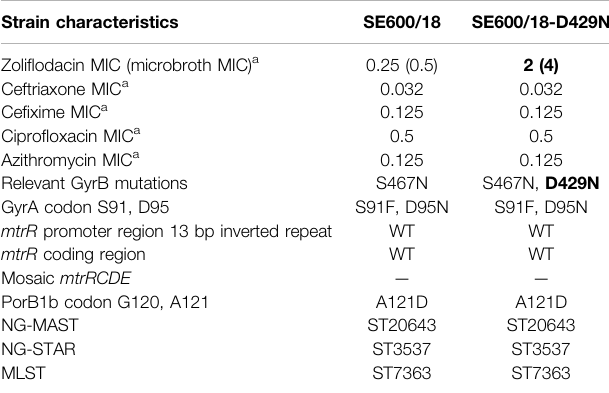
TABLE 1 | Relevant phenotypic and genetic characteristics of N. gonorrhoeae strains. Differences between the clinical SE600/18 isolate and the SE600/18- D429N mutant selected in the HFIM are in bold